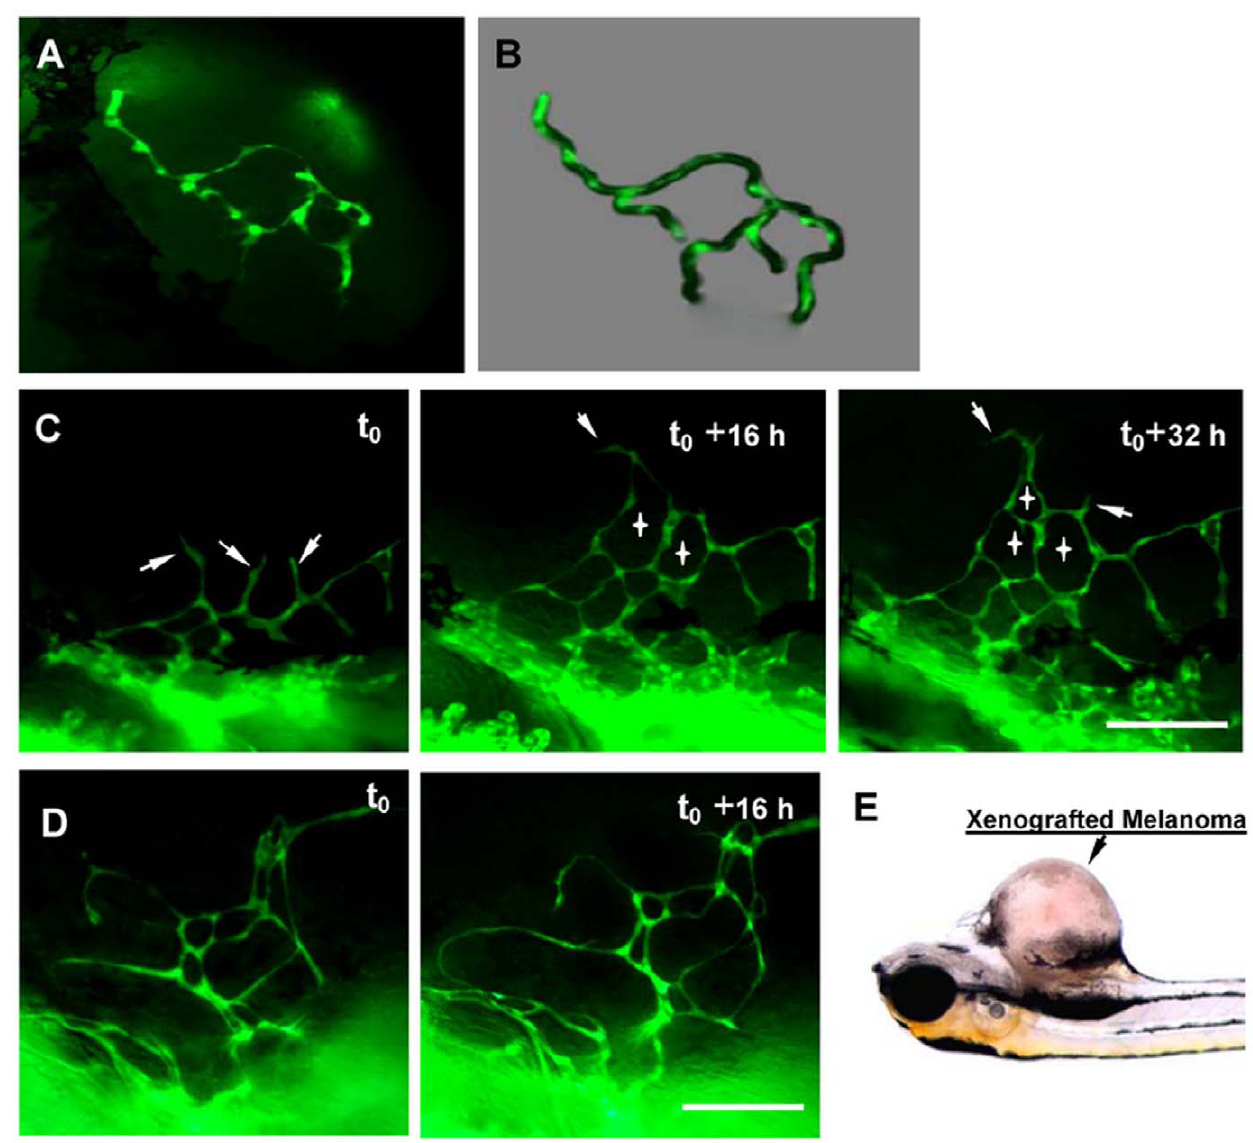
Figure 4. The formation of chaotic microvascular network in B16 xenografts. ( A ) The interconnection of initial endothelial cells that had penetrated into tumor tissue. (B) Schematic diagram showing the forming and formed endothelial loops. (C) The dynamic process of more and more endothelial loops assembling into a complex vascular network. Angiogenic sprouts were indicated by arrows, the formed endothelial loops were indicated by crosses. (D) Endothelial loops varied significantly in size and shape. The B16 xenograft is indicated by arrow (E). Scale bars, 200 m